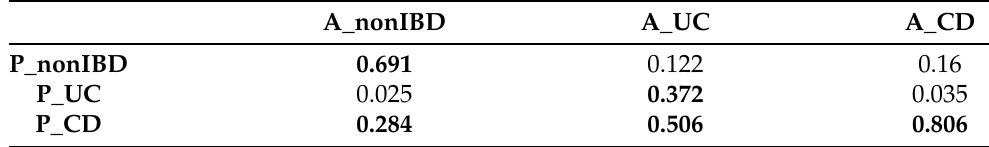
Table A4. Summaries IBD (A discrete uniform